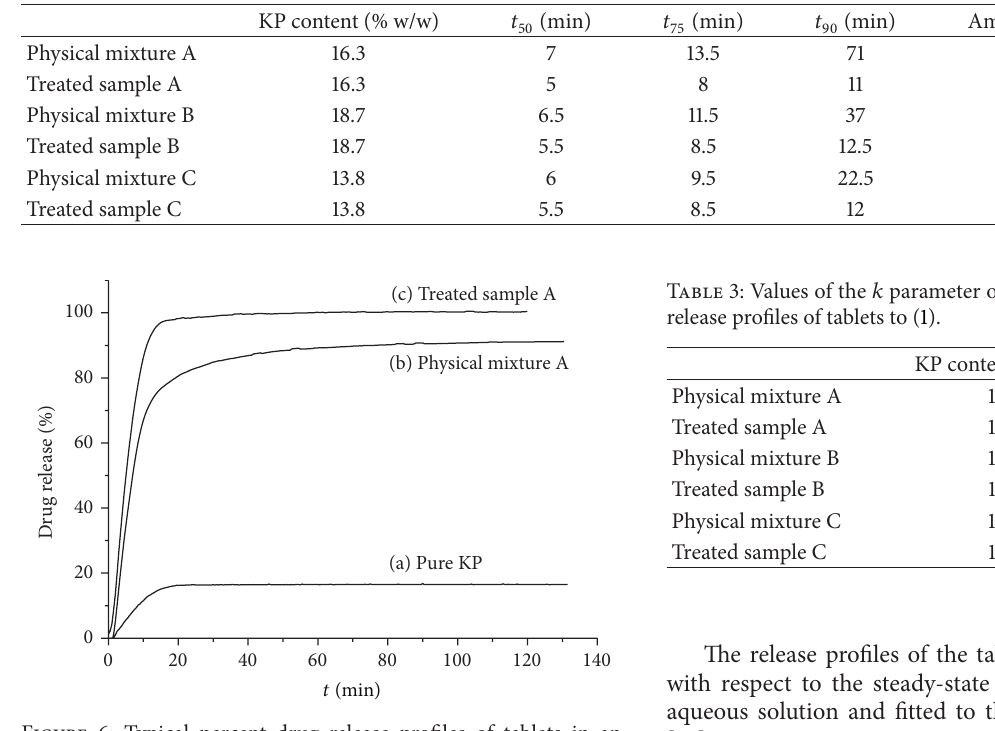
Figure 6: Typical percent drug release profiles of tablets in an aqueous solution at pH = 2 : (a) tablet of pure KP, (b) KP :Me 𝛽 CD physical mixture A (16.3% KP), and (c) KP :Me 𝛽 CD sample A (16.3% KP) treated at 40 ∘ C, 20MPa, 1h.